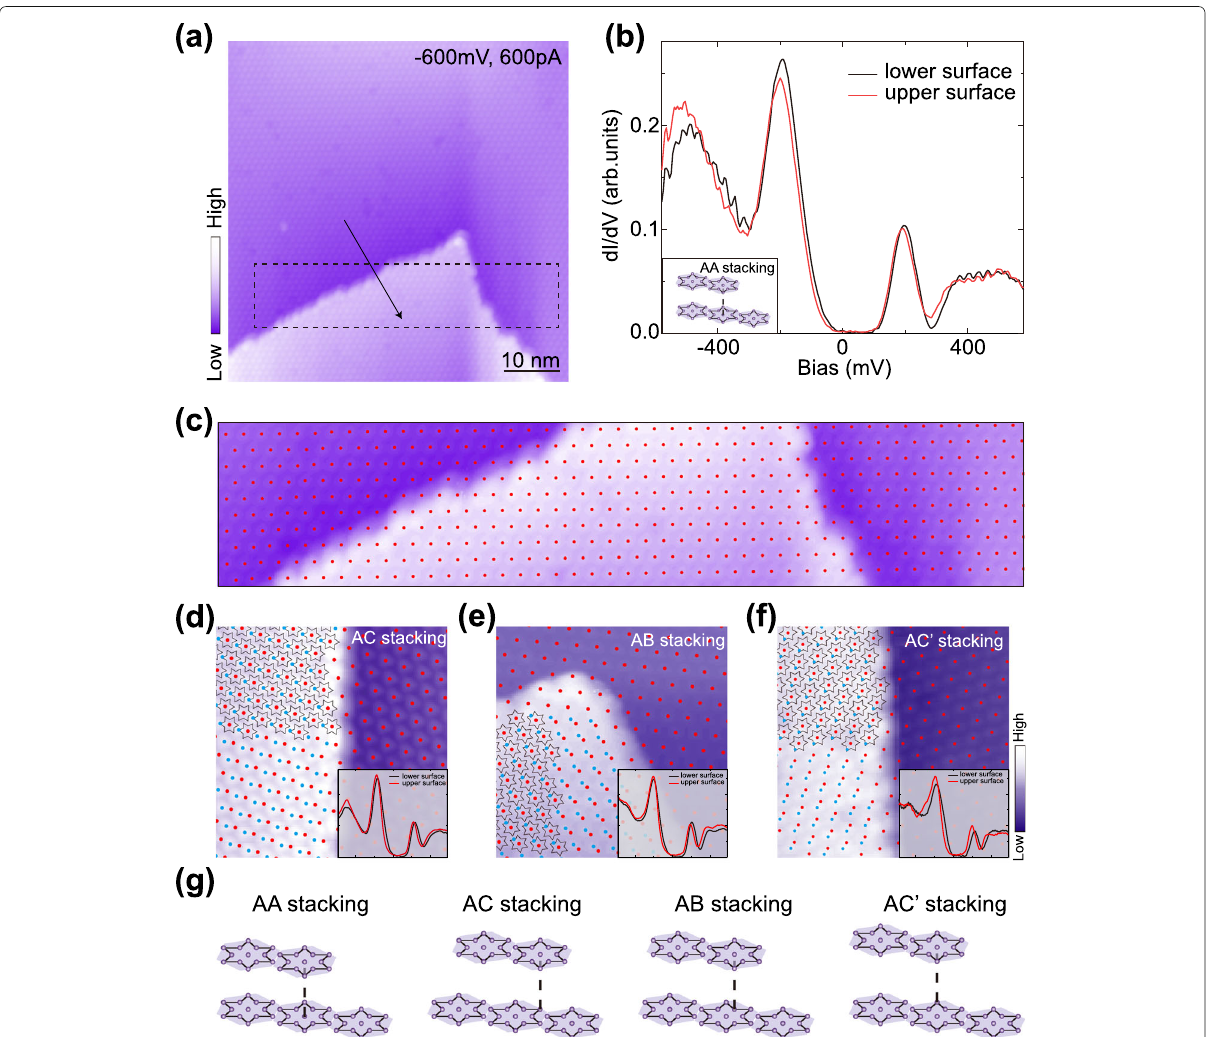
Fig. 4 Single-step areas of different stacking orders in bulk 1 T -TaS 2 , all with a large-gap spectrum on the top layer . a STM topography of the single-step area with AA-stacking. b dI / dV spectra on the upper and lower terraces. c The determination of SD superlattice for the area within the black dashed frame in a . d – f Three misaligned examples on the single-step area. The red (blue) dots label SD centers in the lower (upper) layer. g Schematic diagrams of the AA, AC, AB, and AC’ stacking orders. Taken from ref.